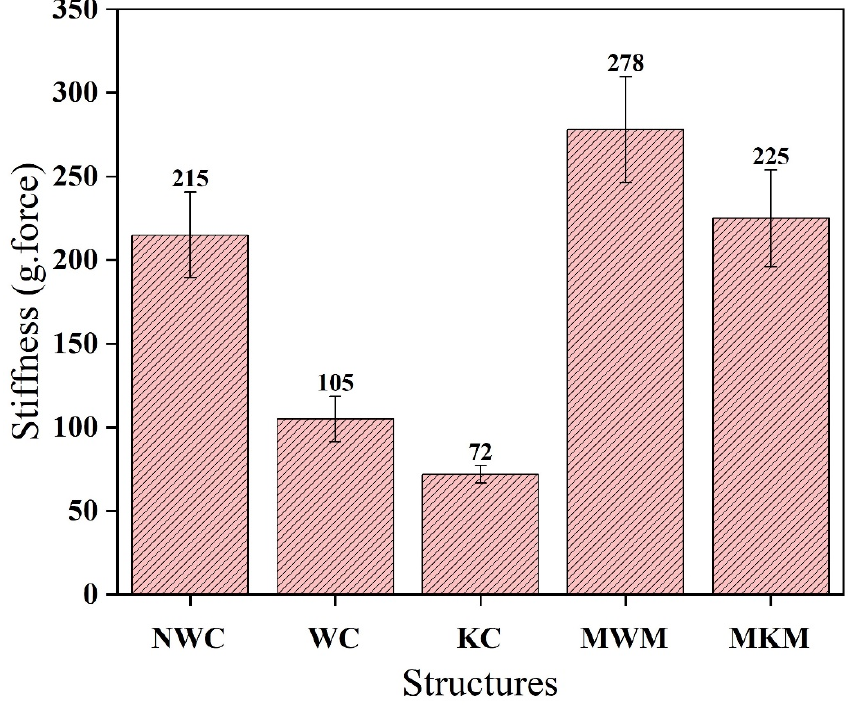
Figure 15. Comparison of the stiffness of composites developed against reference meshes.